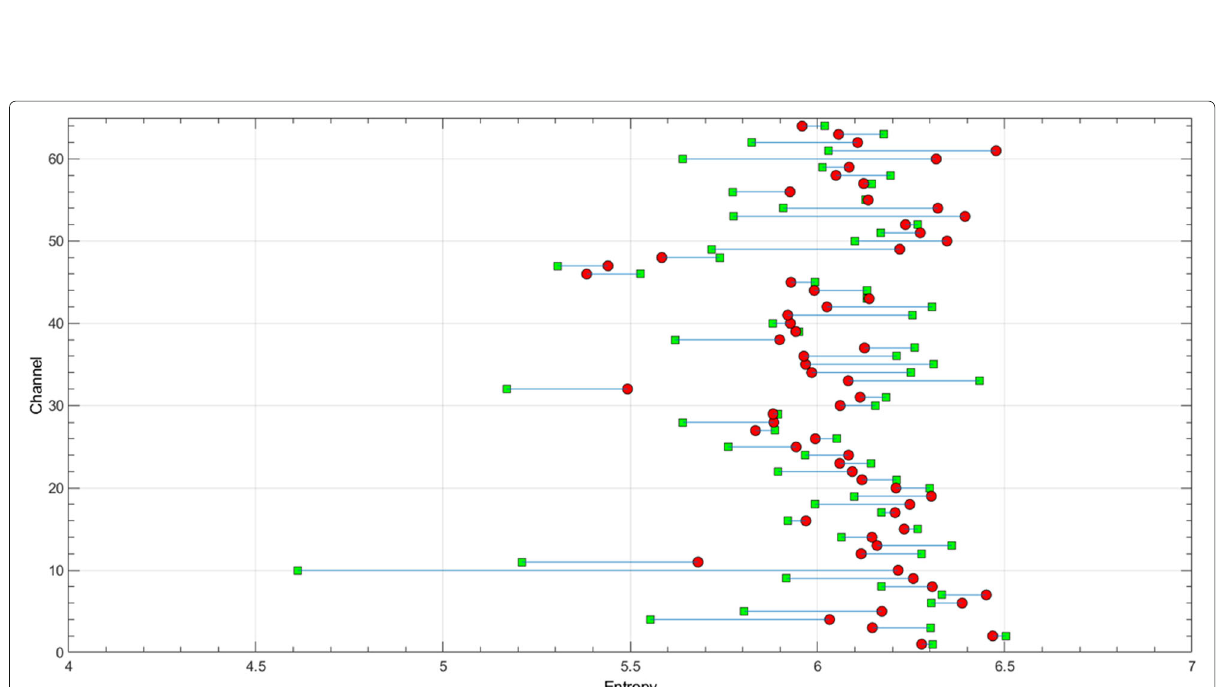
Fig. 11 Electrode F6. a Time domain representation of ERP. b SPWVD time-frequency representation . c Short-term Rényi entropy of the distribution